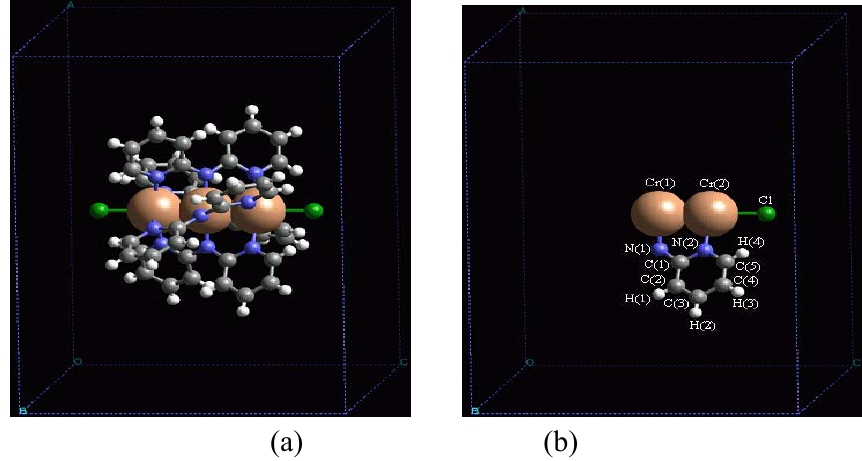
(µ -dpa) Cl . (a) is the complete structure and (b)is its 3 3 4 2 3